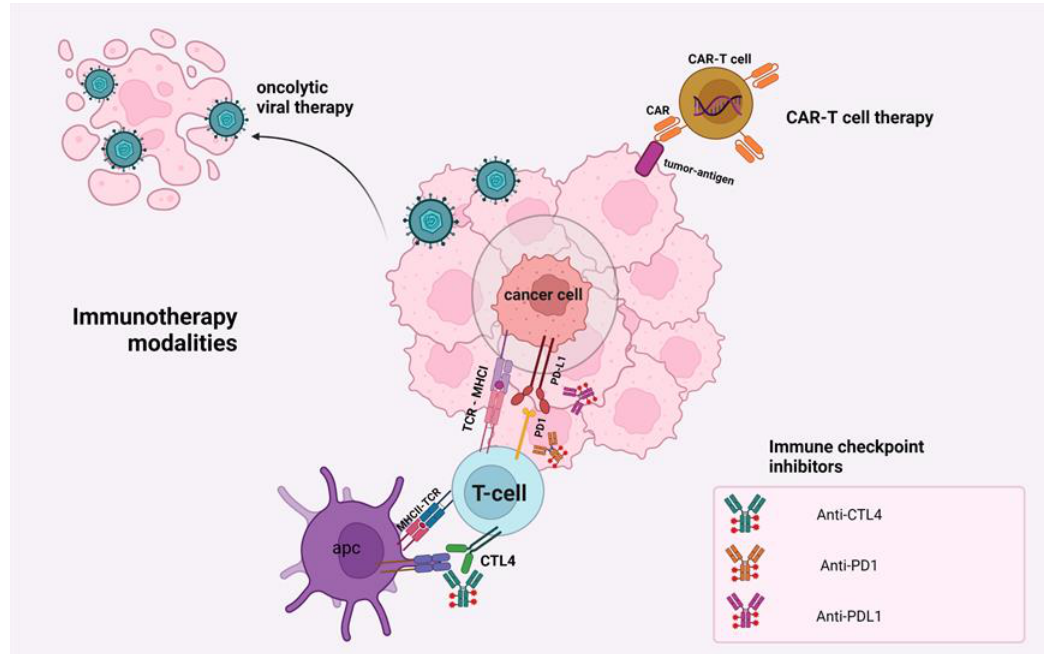
Figure 2. Schematic presentation of immunotherapy modalities and their associated targets. There is a wide range of immunotherapeutic modalities that are introduced in the GI cancer management, including immune checkpoint inhibitors, adoptive cell transfer, chimeric antigen receptor (CAR)-T cell therapy, cancer vaccines, and/or combinations of all the aforementioned. This figure was created with BioRender.com (agreement number HP23X0I0W3).